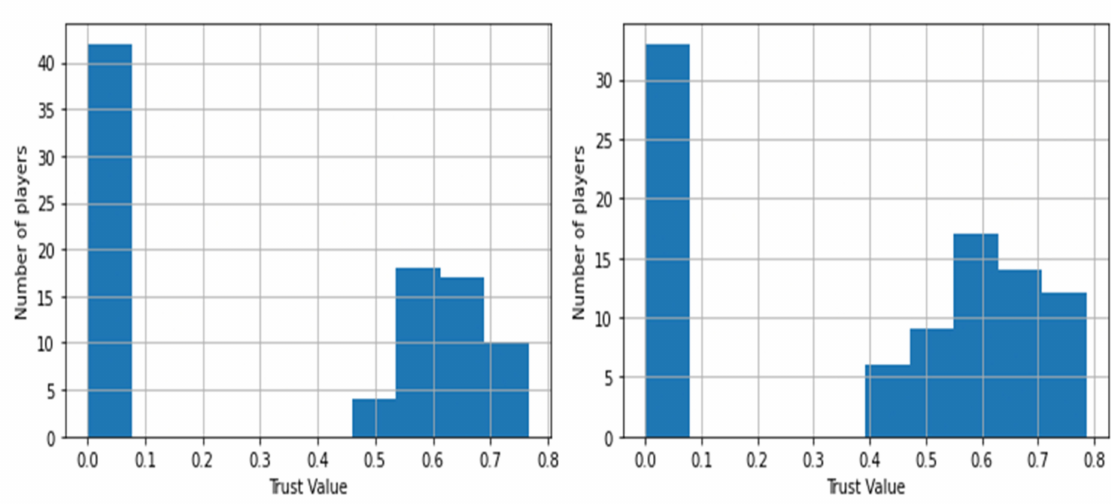
Figure 12. Histograms for 73rd and 74th time step from the